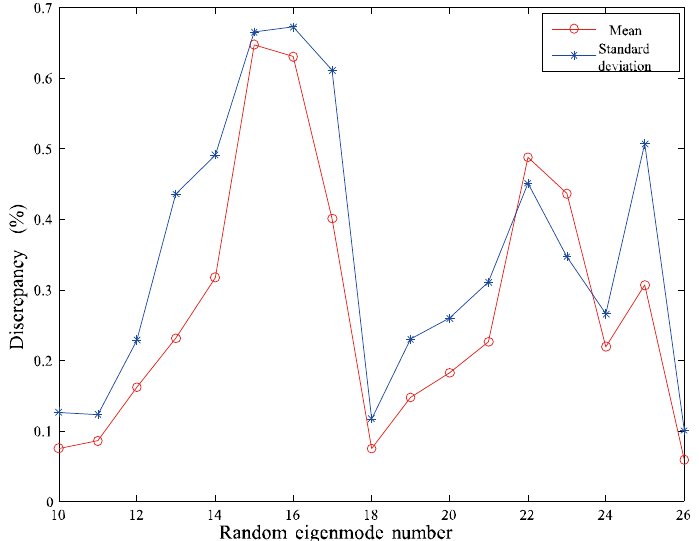
Fig. 7. Mean and standard deviation of the discrepancy between Monte-Carlo and chaos, for each random eigenmode, and for a standard devi- ation of 1%.